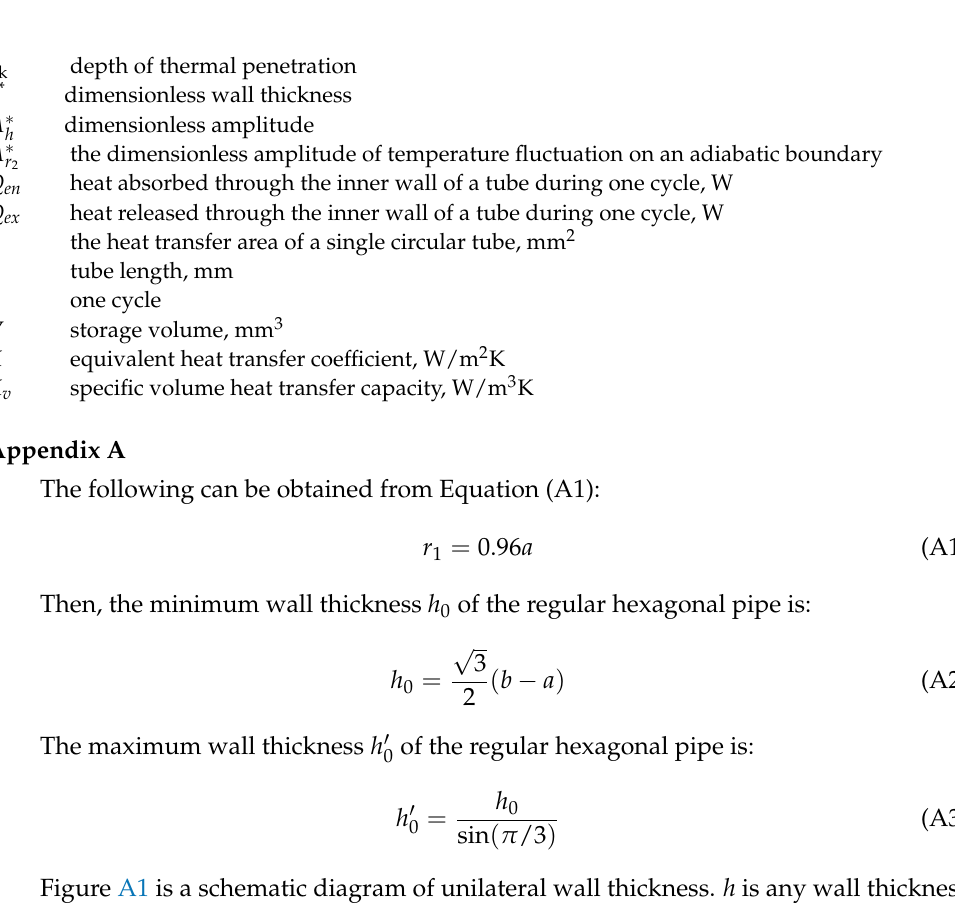
Figure A1 is a schematic diagram of unilateral wall thickness. h is any wall thickness